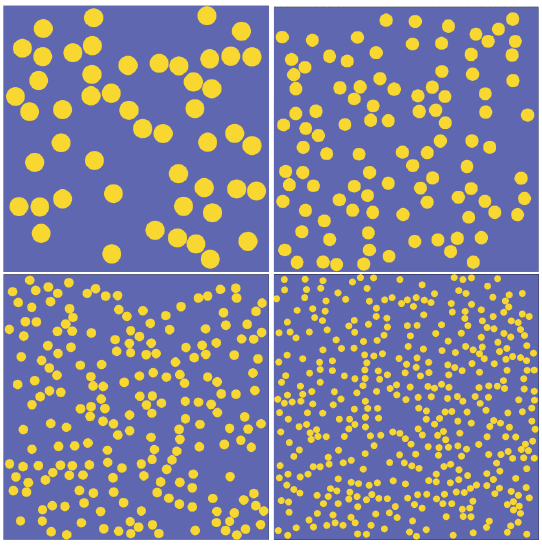
Figure 2: The generated random models with 50, 100, 200 and 400 fibers for v f = 20%